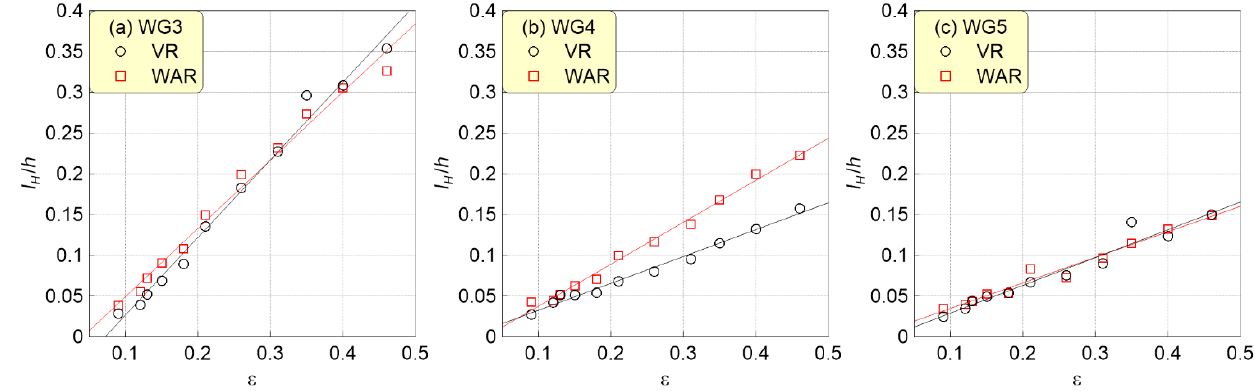
Figure 7. Distributions of maximum inundation heights according to 𝜀 at the VR and WAR.